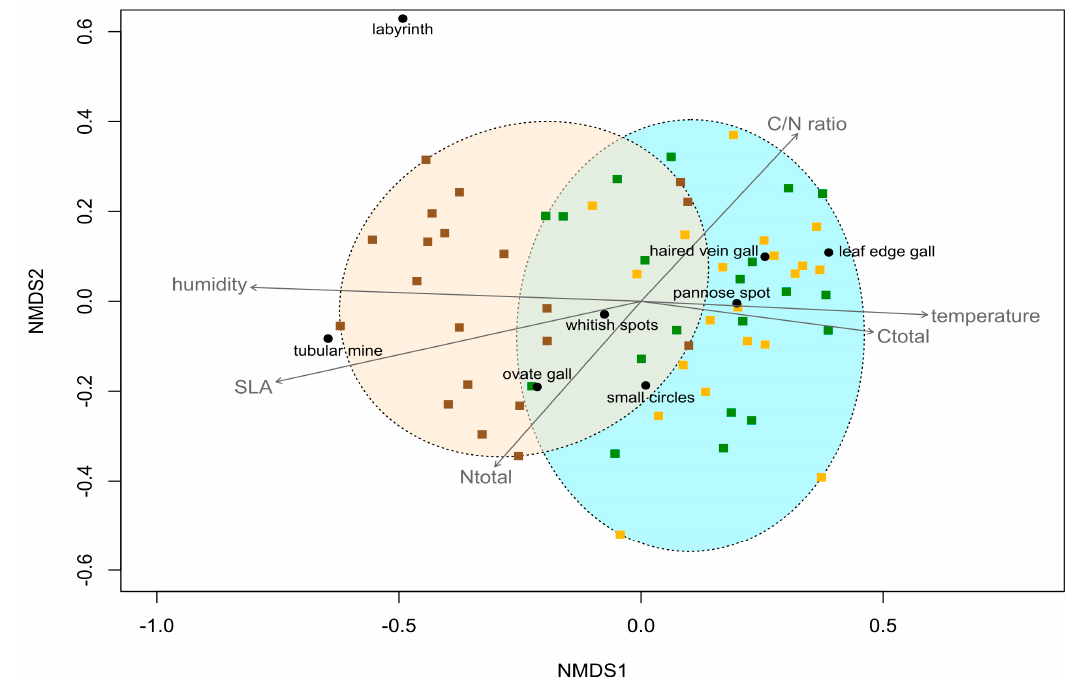
Figure 4. Ordination of samples and arthropod herbivore attack levels in a biplot with non-metric multidimensional scaling (NMDS). Each point of a sample site represents the composition of herbivore attack levels. Herbivore attack levels caused by identified feeding traces (black circles) are orientated along microclimate (temperature, humidity) and leaf traits (SLA, Ctotal, Ntotal, C/N ratio) parameter axes (post-hoc correlations). Sample sites along the vertical forest gradient are presented for the understorey (brown squares), lower canopy (green squares), and upper canopy (yellow squares), representing juvenile (beige ellipse) and adult (blue ellipse) Fagus sylvatica . Non-metric multidimensional scaling is based on Bray-Curtis dissimilarity (stress = 0.187 (usable)). Temperature ( R 2 = 0.249, p = 0.002), humidity ( R 2 = 0.461, p = 0.001), SLA ( R 2 = 0.426, p = 0.001), Ctotal ( R 2 = 0.167, p = 0.007), Ntotal ( R 2 = 0.161, p = 0.009), and C/N ratio ( R 2 = 0.173, p = 0.005) parameters represent significant axes for the NMDS ordination. Temperature = air temperature; humidity = relative